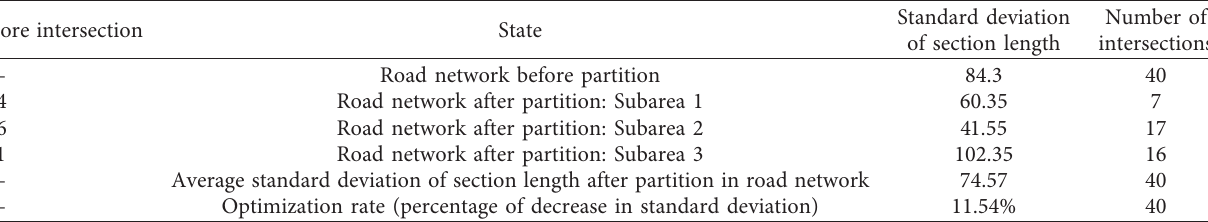
Table 5: Traffic section length standard deviation before and after static partition.